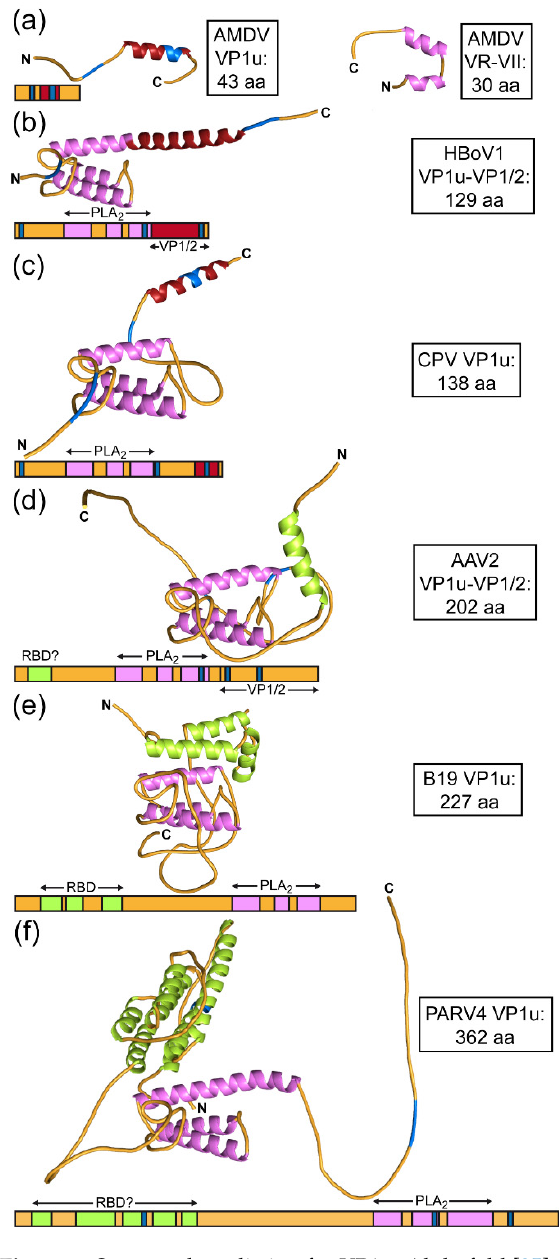
Figure 6. Structural prediction for VP1u. Alphafold [35] predictions utilizing the primary sequences of ( a ) the AMDV VP1u and VR-VII regions, ( b ) the HBoV1 VP1u and VP1/2 common region, ( c ) the CPV VP1u, ( d ) the AAV2 VP1u and VP1/2 common region, ( e ) the B19 VP1u, and ( f ) the PARV4 VP1u. The helices of the PLA2 domains are colored magenta, the helices of (potential) receptor-binding domains (RBD) light green, the C-terminal helices dark red, and the basic regions blue. The N- and C-termini are indicated.